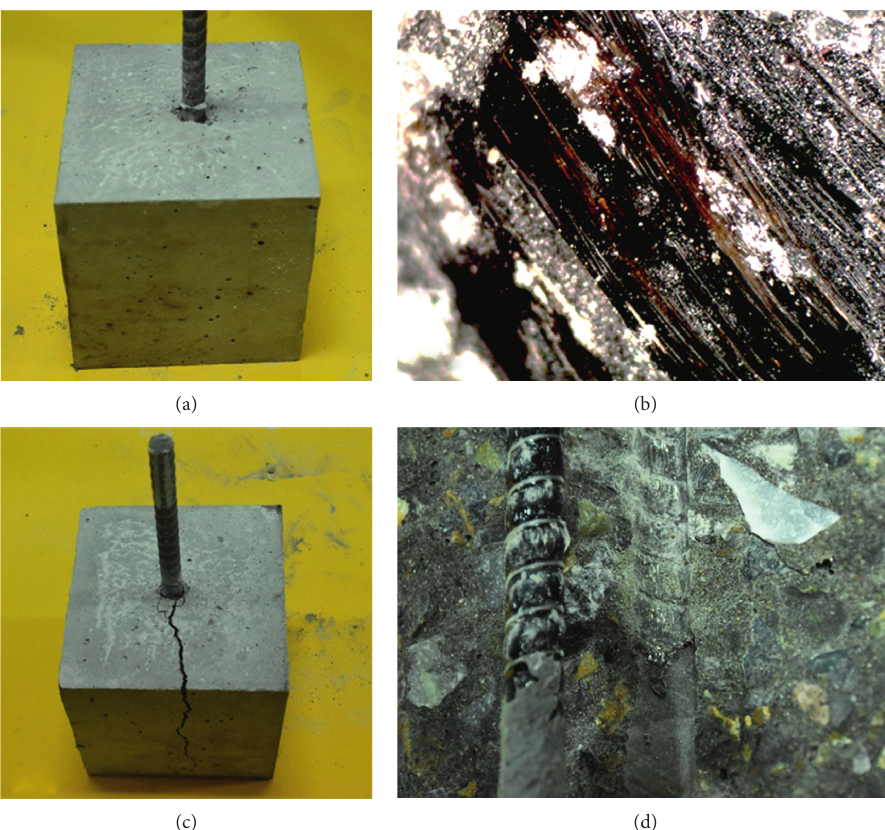
Figure 5: Typical failure modes of pullout specimens with (a) sand coated rebar and (c) rebar with ribs. The detailed examinations of surfaces of these two rebars are shown in (b) and (d),